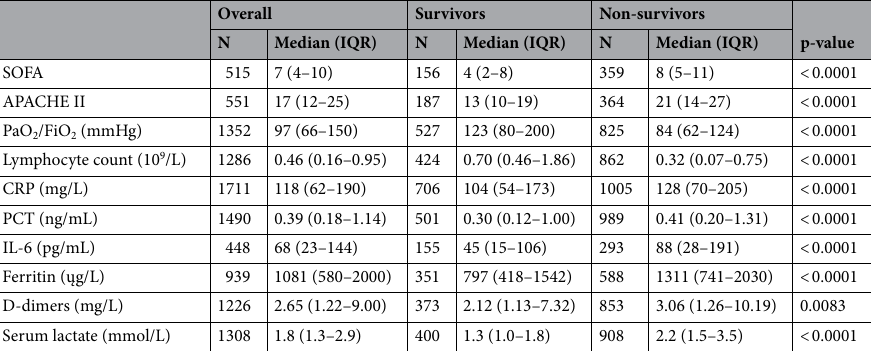
Table 3. Baseline parameters on ICU admission. Data are presented as median (25–75th percentile). For statistical analysis Mann–Whitney U test was used. IQR interquartile range, SOFA Sequential Organ